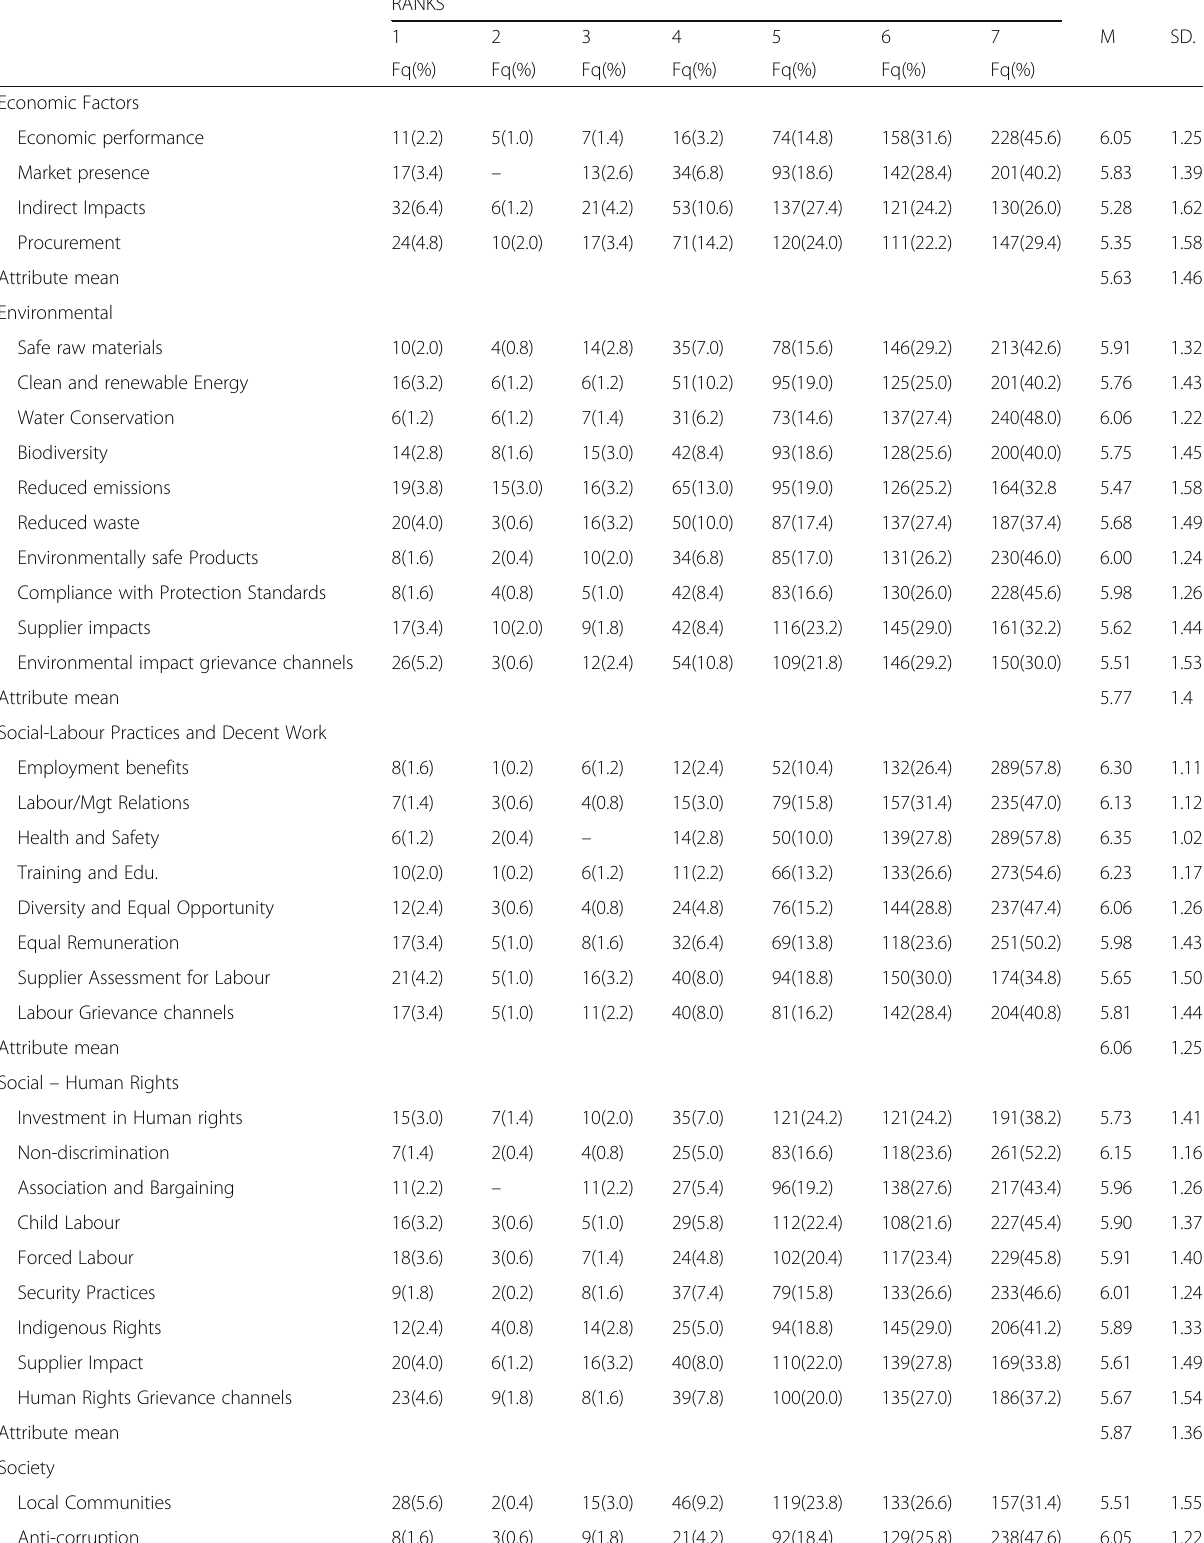
Table 4 CSRP disclosures and Job